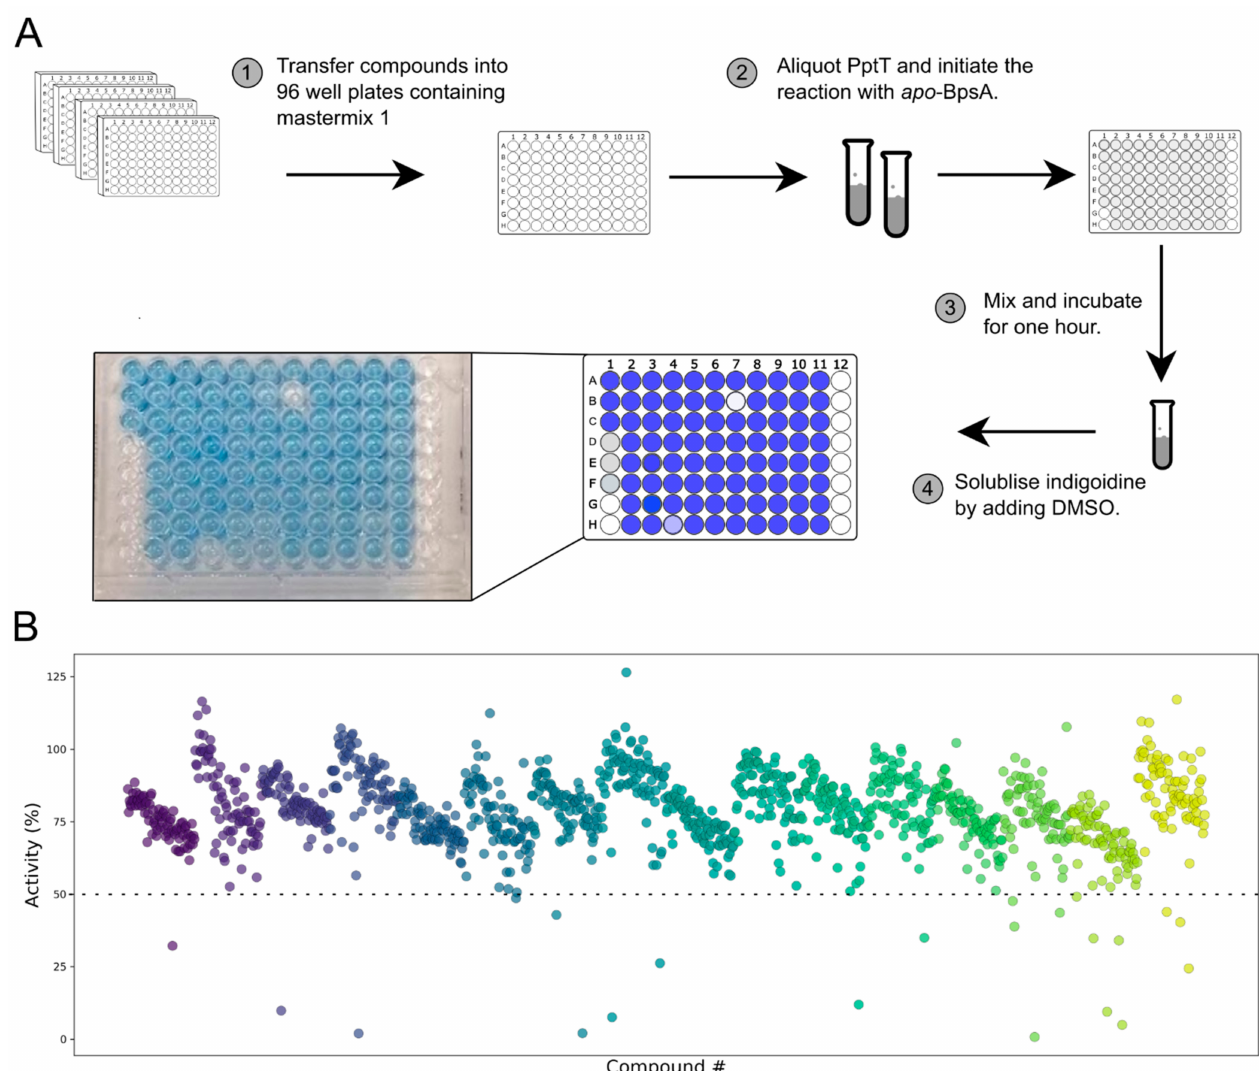
Figure 3. High-throughput screening of the LOPAC 1280 library: ( A ) schematic diagram illustrating the screening process; ( B ) percentage activity of each compound in the library, with data derived from distinct 96 well plates presented in different